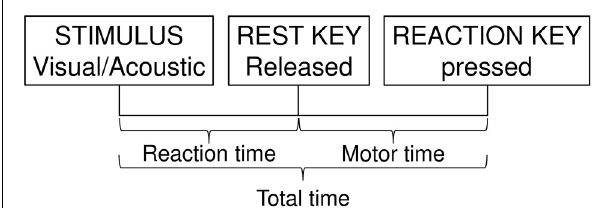
FIGURE 1 | Psychomotor performance test. The subjects were instructed to press a reaction key when specific stimuli were presented and, having pressed the key, to return their finger immediately to the rest key. Mean reaction time (stimulus onset-reaction key pressed) and mean motor time (rest key released-reaction key pressed) were measured (the mean values for 28 warning signals from both tests). In the first part of the test the stimulus was visual (a yellow light), and in the second part, an acoustic stimulus (a